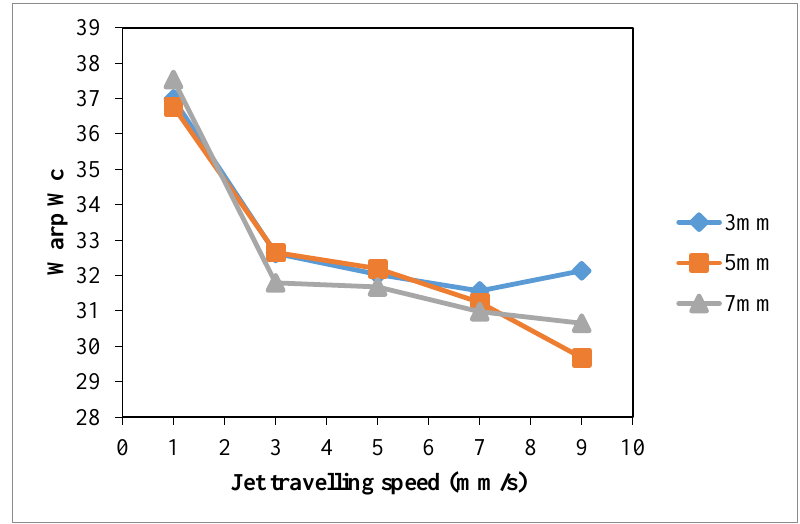
Figure 10. Effect of jet travelling speed on warp W c (Jet travelling speed: 1 mm/s, 3 mm/s, 5 mm/s, 7 mm/s and 9 mm/s; Jet-to-substrate distances: 3 mm, 5 mm and 7 mm; Discharge power: 150 W and Oxygen flow rate: 0.4